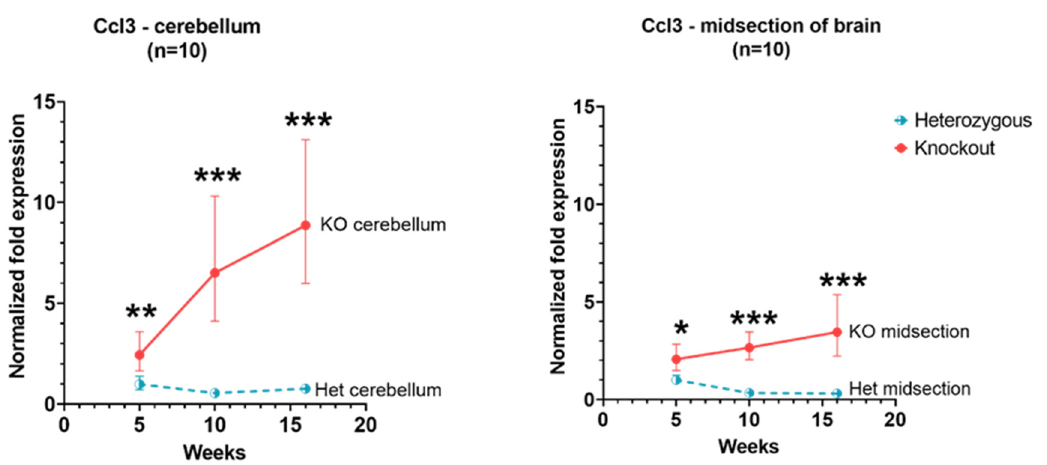
Figure 2. Relative Ccl3 expression in the cerebellum and cerebral cortex of Hexb -KO Sandhoff disease mouse model (*— p value < 0.05; **— p value < 0.01; ***— p value < 0.001; midsection of brain represents cerebral cortex).